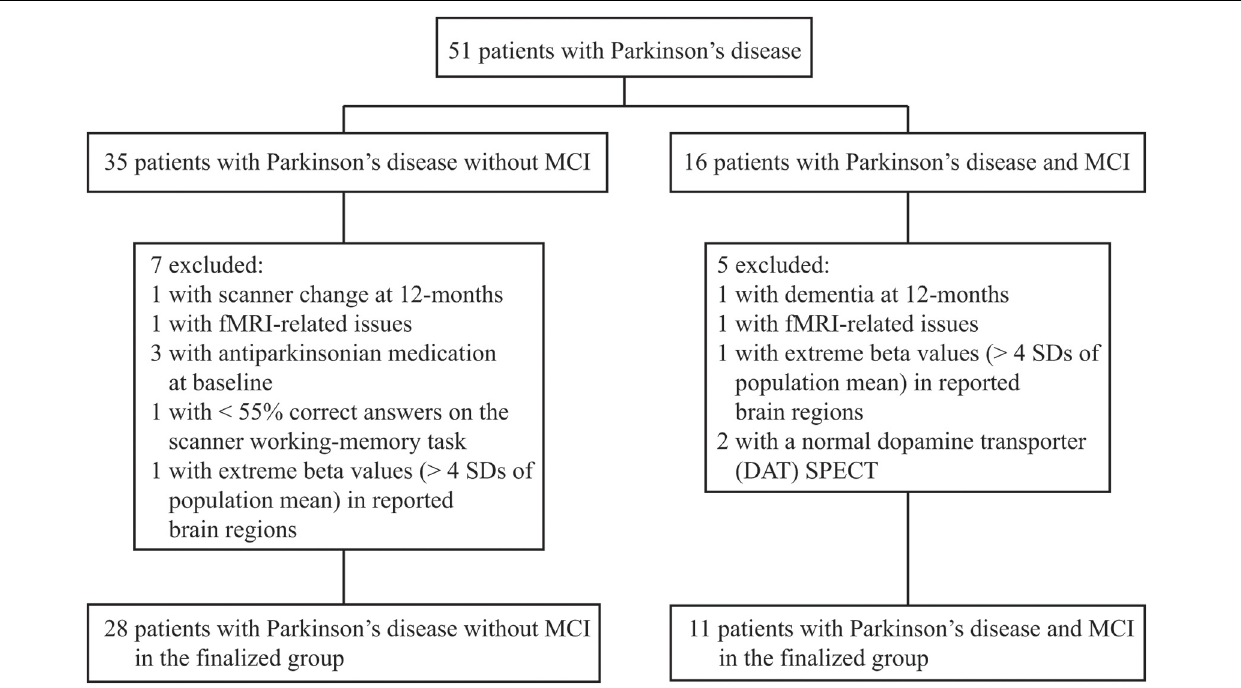
FIGURE 1 | Flow-chart of study profile. Of 67 enrolled Parkinson’s disease patients, 51 had conducted neuropsychological assessments and fMRI at both time-points with either a manifested MCI or were cognitive stable. SD, standard deviation.